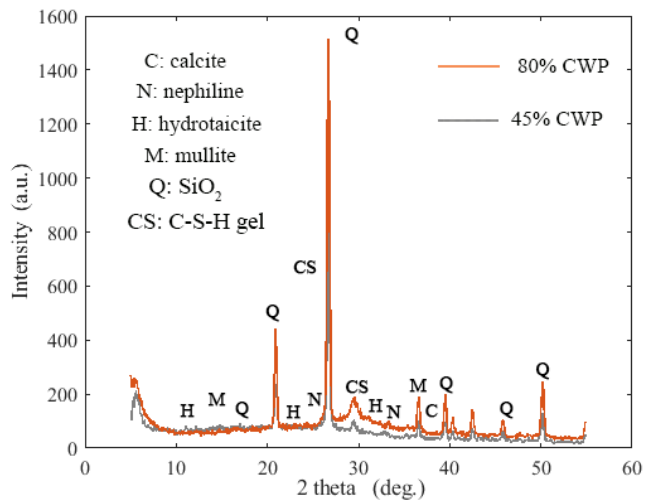
Figure 4. Strength evolution in the proposed concrete: ( a ) CS, ( b ) TS, and ( c ) FS. In the same regard, X-ray diffraction (XRD) analysis was also taken into account to analyse and support the results of the proposed SCAAC containing a high amount of CWP (45% and 80%). As shown in Figure 5, the hydrotalcite (Mg 6 Al 2 CO 3 OH 16 .4H 2 O) phase emerged at a peak around 10° [39]. In addition, a reduction in the C-S-H peak intensity was observed at 30° with increasing CWP concentration. The C-S-H is most probably sub- stituted by hydrotalcite at the peak 43° with the replacement percentage of GBFS by CWP of 80%. Similarly, calcite was found to be substituted by quartz at peaks at 17°, 21°, 28°, 38.5°, and 51° when the amount of CWP was higher than 45%. It is also remarkable to note that increasing the CWP level leads to a decreased C-S-H product and an increased non- reacted silicate quantity, which confirmed the previous results where the concrete strength dropped from 70.1 to 26.2 MPa after 28 days. This is also in line with the previous literature [40], in which the productivity of the C-S-H gel and the calcite formulation could be diminished owing to the low CaO content. Moreover, the formation of C-S-H gel, N- A-S-H gel, and calcite was also detected [41].